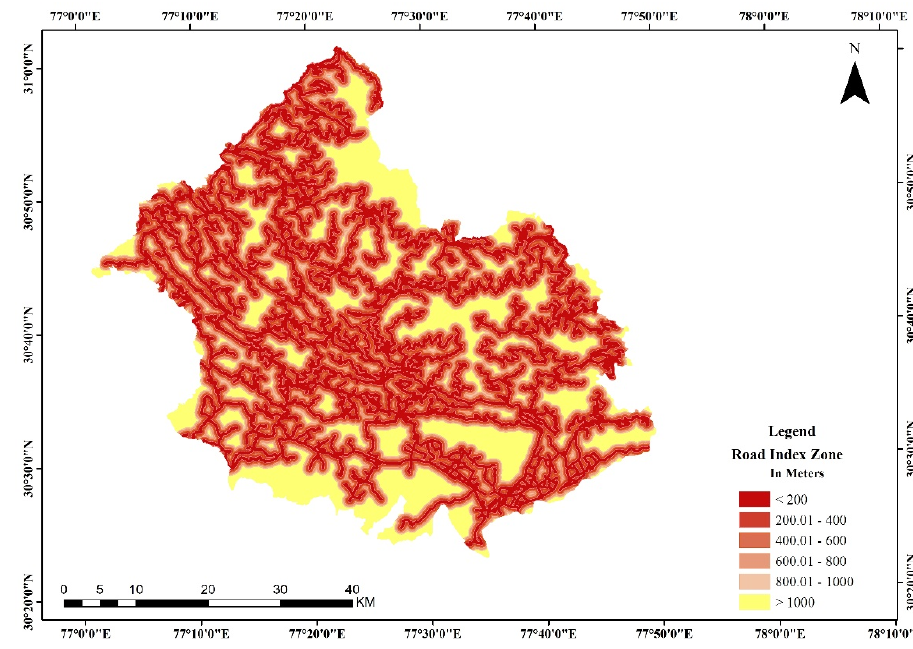
Figure 7. Road buffer map.